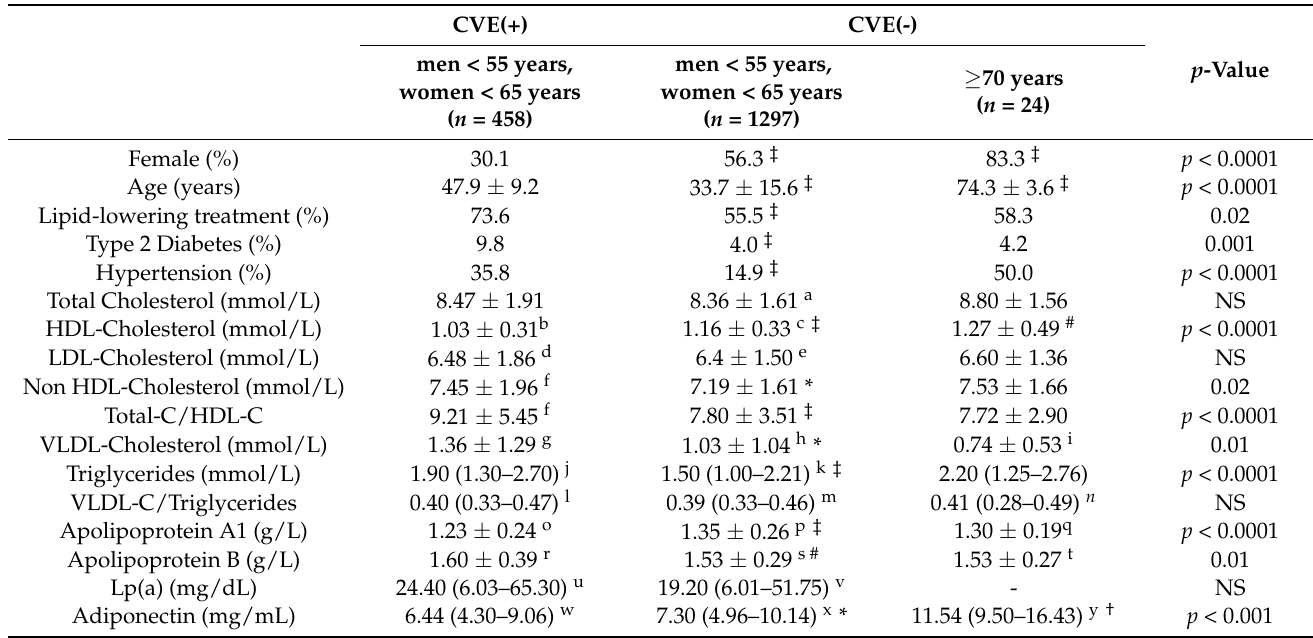
Table 1. Identification of biological markers associated with cardiovascular events (CVE)-free survival in patients with familial